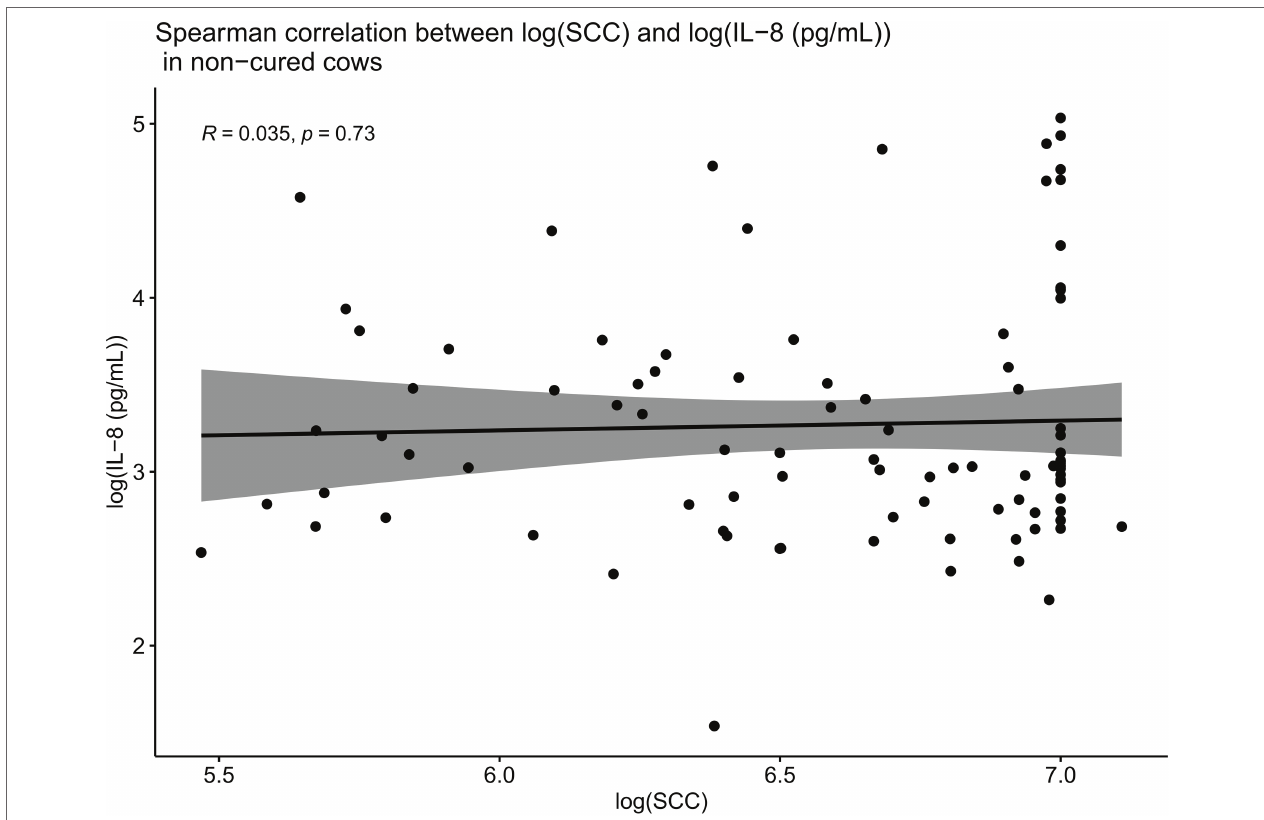
FIGURE 8 | Spearman correlations between IL-8 values and SCC values in cows which were not cured. When compared overall for cows which were not cured, SCC and IL-8 are no longer positively correlated ( R = 0.035, p = 0.73). This suggests that these cows were likely unable to mount a sufficient localized IL-8 response, leading to inadequate recruitment of PMNs to the site of infection. This insufficient localized IL-8 response may explain why such cows were unable to combat the infection and thereby remained